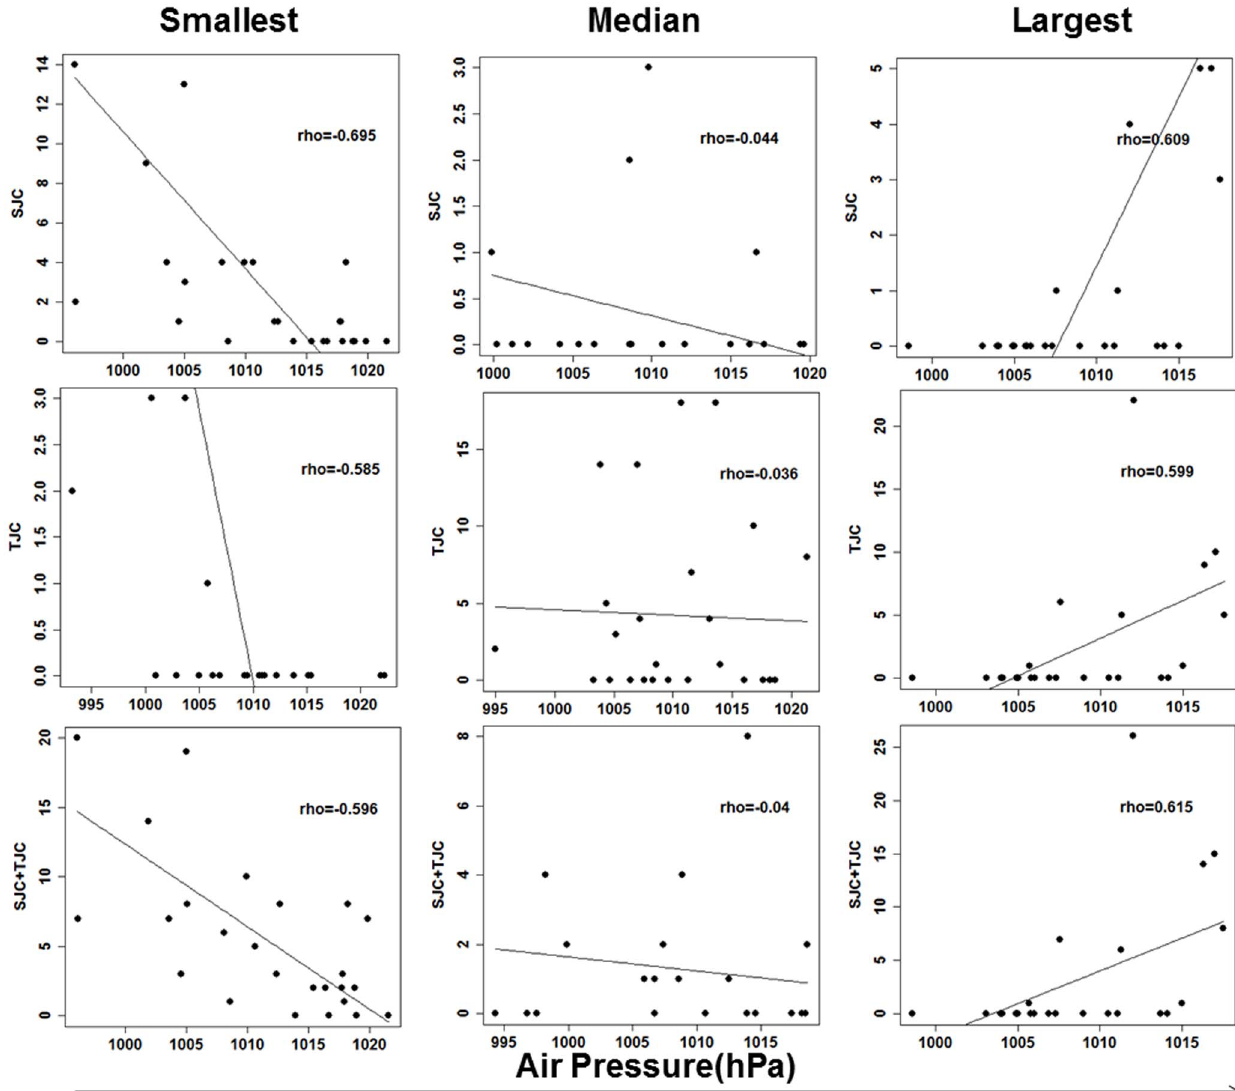
Figure 1. Correlations between joint synovitis and air pressure in RA patients. Correlation plots in patients demonstrating the smallest, median and largest correlation coefficients between joint synovitis and air pressure are illustrated in the left, middle and right panels, respectively.